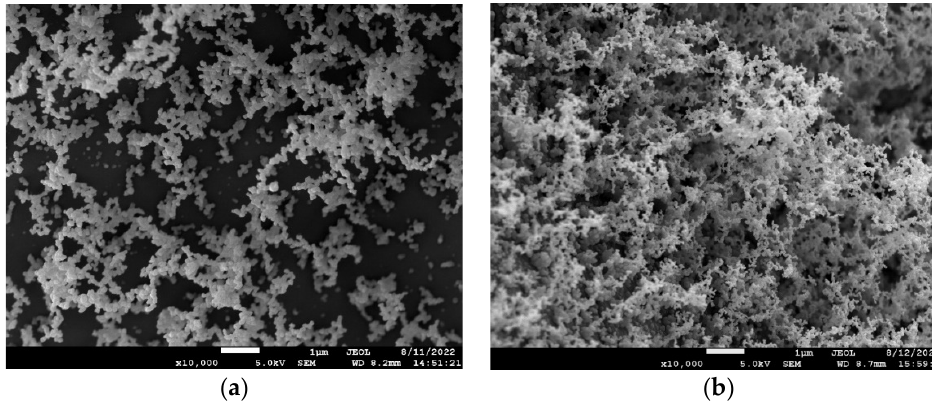
Figure 9. FESEM image of char residue: ( a ) Pure EP ( b ) EP/ 4b .